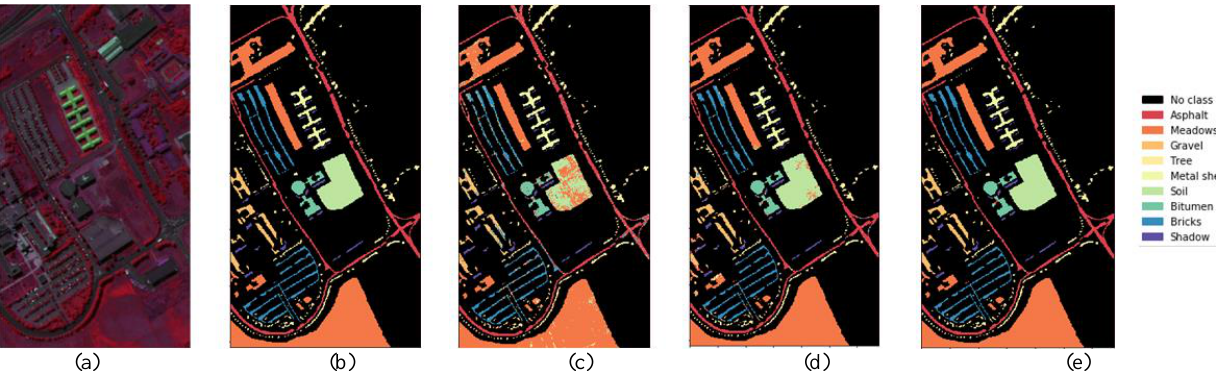
Figure 6. Best classification results of the Pavia University scene. (a) FCC (b) Ground reference map (c)-(e) classification results by using SAE-LR, CNN,